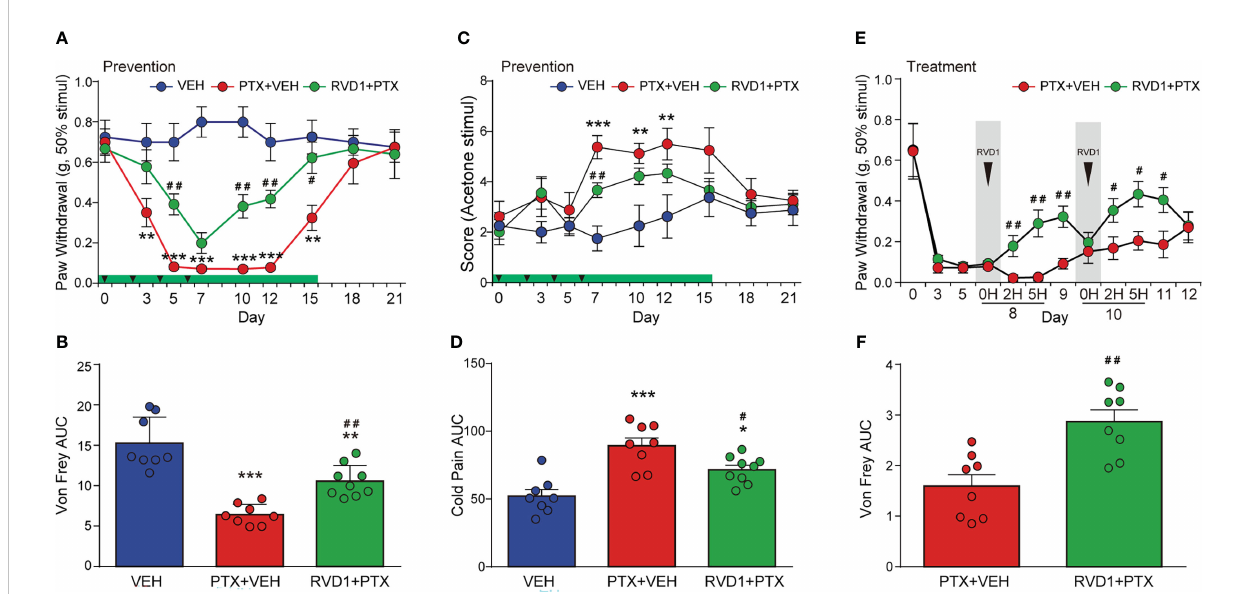
FIGURE 2 Systemic administration of RvD1 reduces PTX-induced mechanical and cold hyperalgesia. Mice were injected with RvD1 (5 m g/kg, ip) 1 day before PTX injection, and injected continuously for 15 days. mechanical pain threshold tested using Von Frey and AUC (A, B) , cold pain score tested using acetone stimulation and AUC (C, D) ; single injection of RvD1 (5 m g/kg, ip) on the 8th and 10th days after the fi rst PTX injection, mechanical pain threshold and AUC of the hind paw of mice (E, F) . *P < 0.05, **P < 0.01, ***P < 0.001 vs VEH group; #P < 0.05, ##P < 0.01 vs PTX group. n=8 in VEH and PTX groups, n=9 in RVD1+PTX group (A – D) ; n=8 in each group (E, F) . RvD1, resolvin D1; PTX, paclitaxel; VEH,